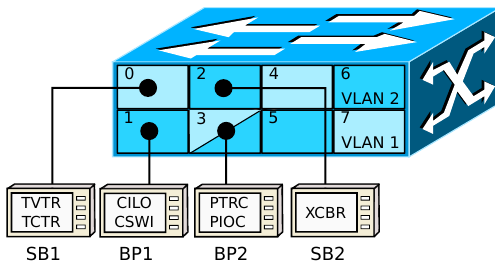
Figure 7. Switch virtual local area networks (VLANs) and port